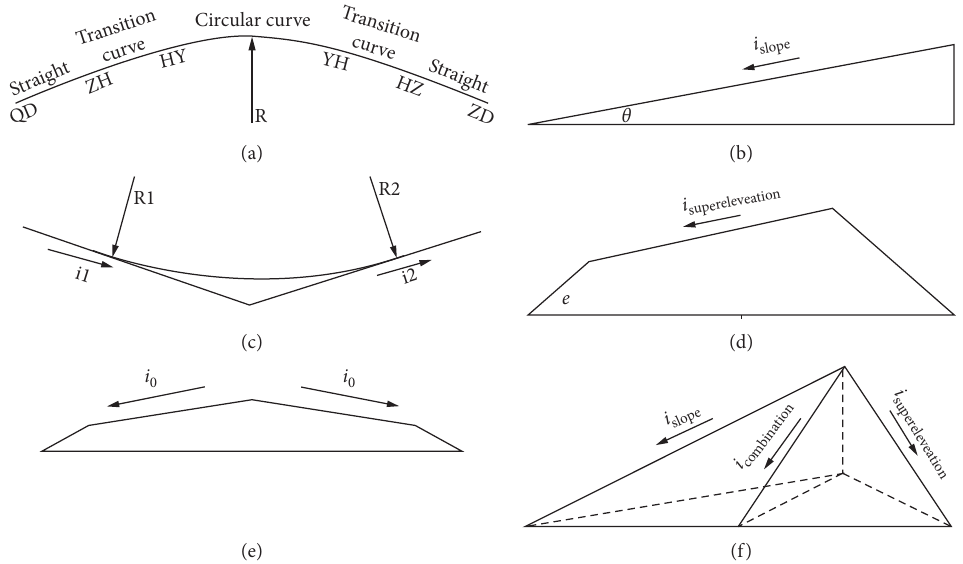
Figure 1: Road geometric design. (a) Horizontal curve. (b) Longitudinal slope. (c) Vertical curve. (d) Superelevation. (e) Road crown. (f) Composite longitudinal